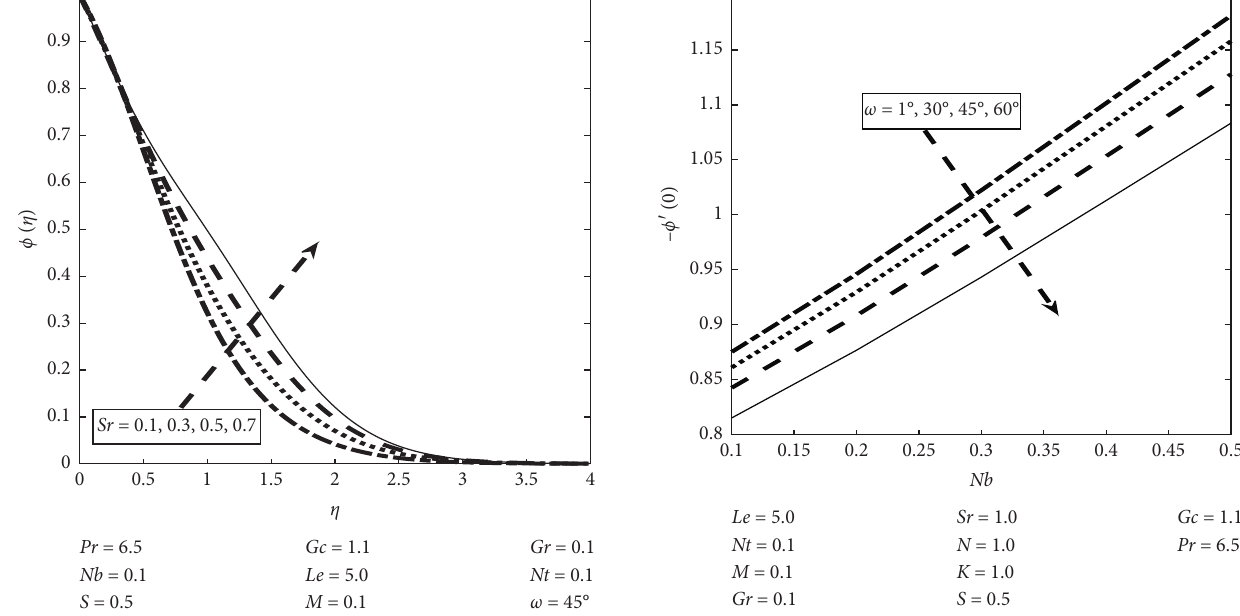
Figure 20: Variations of reduced Sherwood number with Nb for different values of ω .